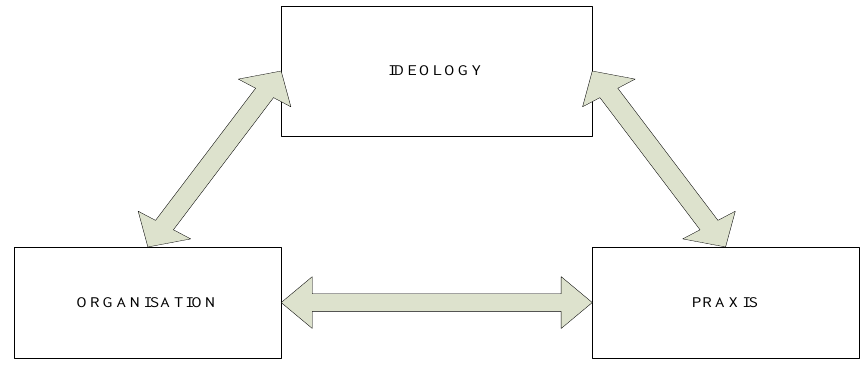
Figure 1: The three components of co-operative movements in developing countries adapted from Develtere (n.d.), page